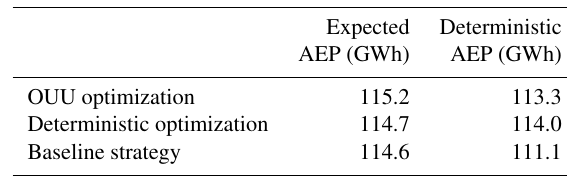
Table 5. Expected and deterministic AEP of OUU, deterministic, and baseline plant-level wake steering strategies for the 11-turbine wind plant test